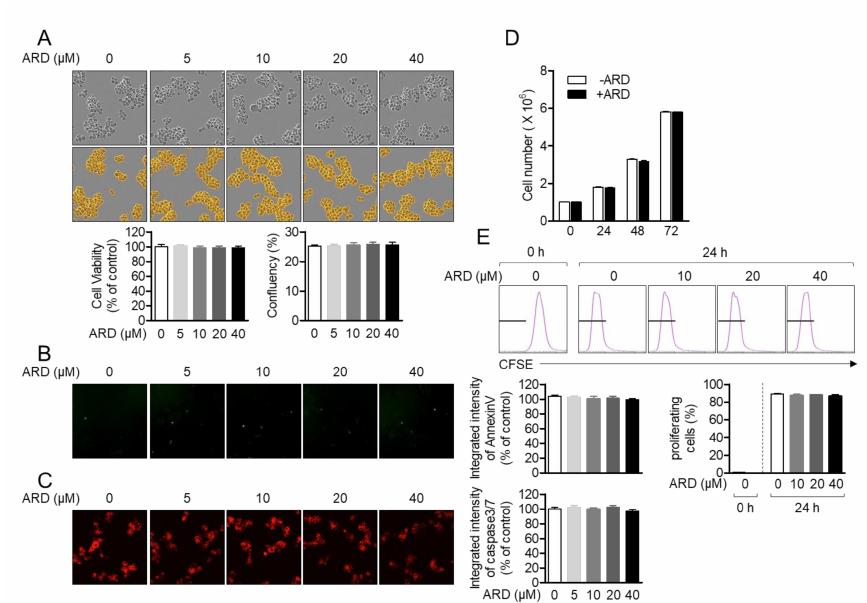
Figure 2. Aromadendrin does not a ff ect T cell viability. ( A ) Cell viability, confluency, ( B ) the expressed AnnexinV, and ( C ) caspase3 / 7 of Jurkat T cells incubated with 40 µ M of aromadendrin for 24 h were